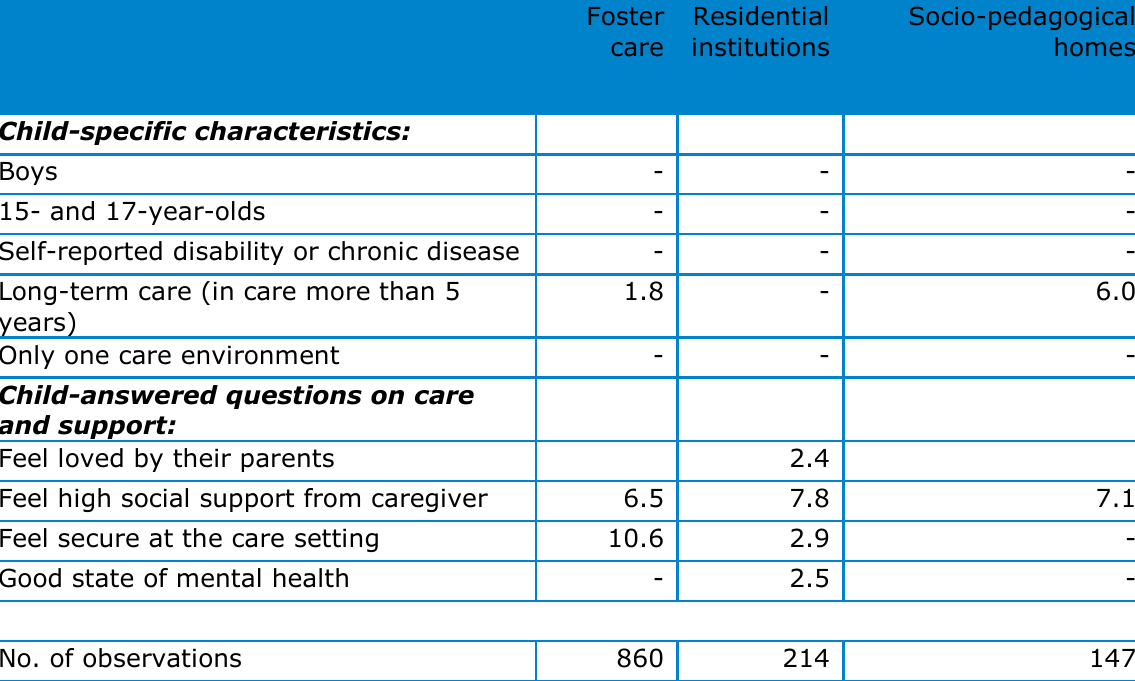
Odds ratios on the probability of feeling loved at the care setting